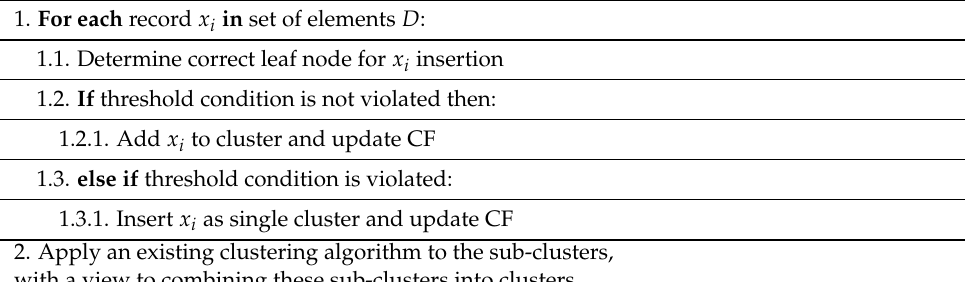
Table 9. Basic BIRCH